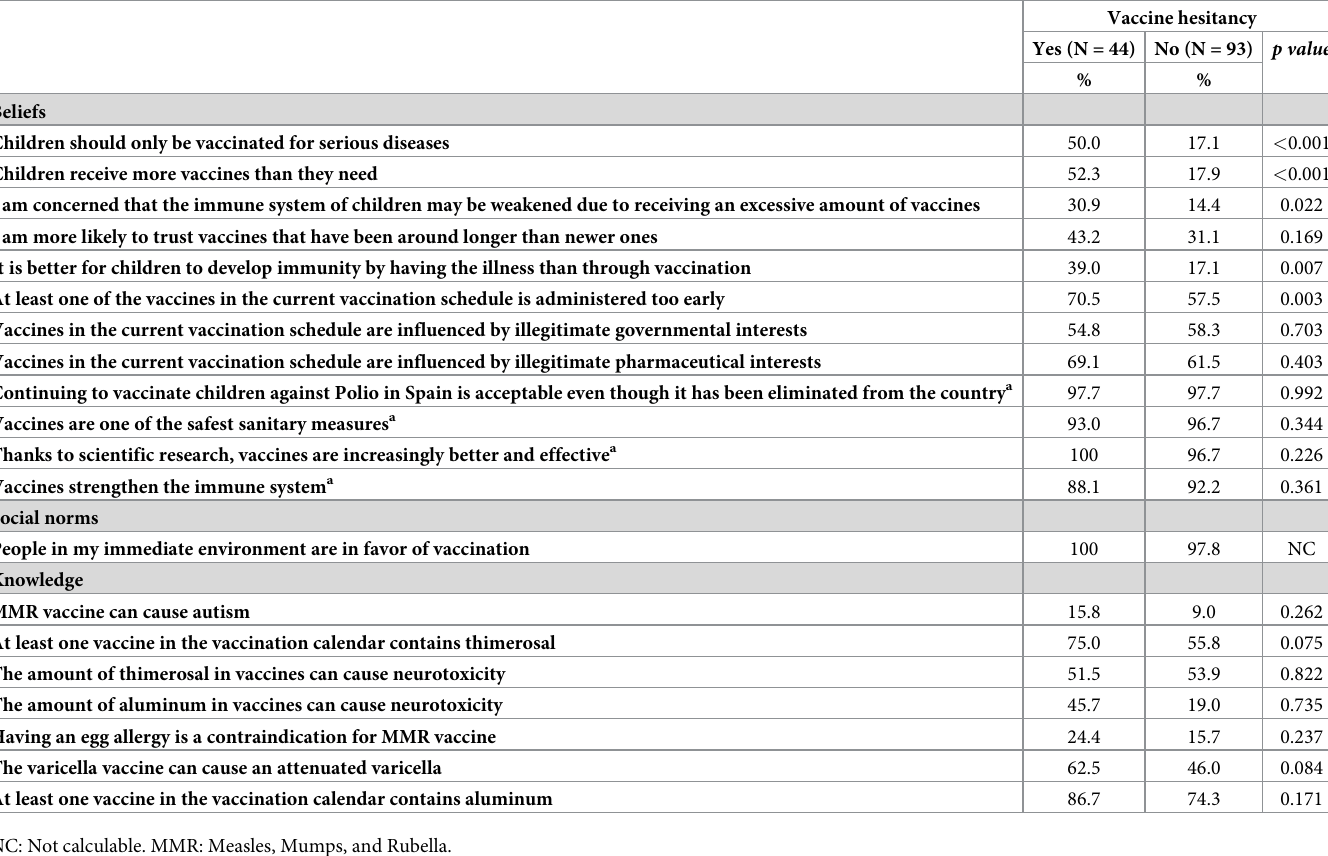
Table 3. Vaccine beliefs, knowledge and social norms by vaccine hesitancy in paediatric nurses. Agreement %. Barcelona. 2016–2017 (N =